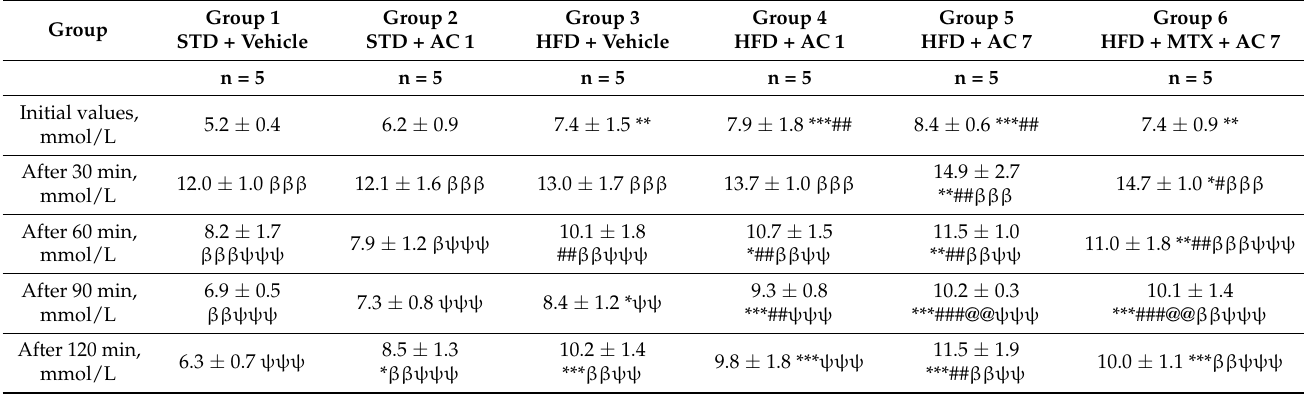
Table 6. Mean values of glucose concentration in the oral glucose tolerance